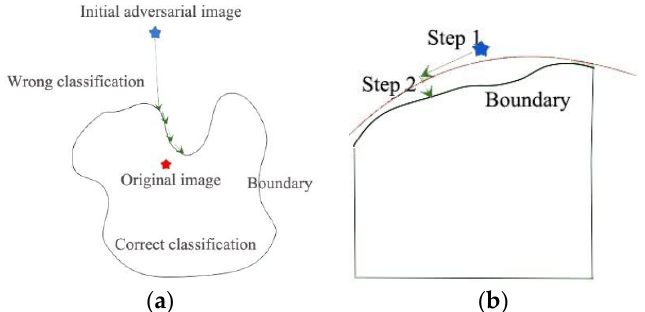
Figure 2. Schematic diagram of boundary attack algorithm. ( a ) Initial adversarial image optimization along boundary ( b ) Move along the orthogonal direction and close to the original image.